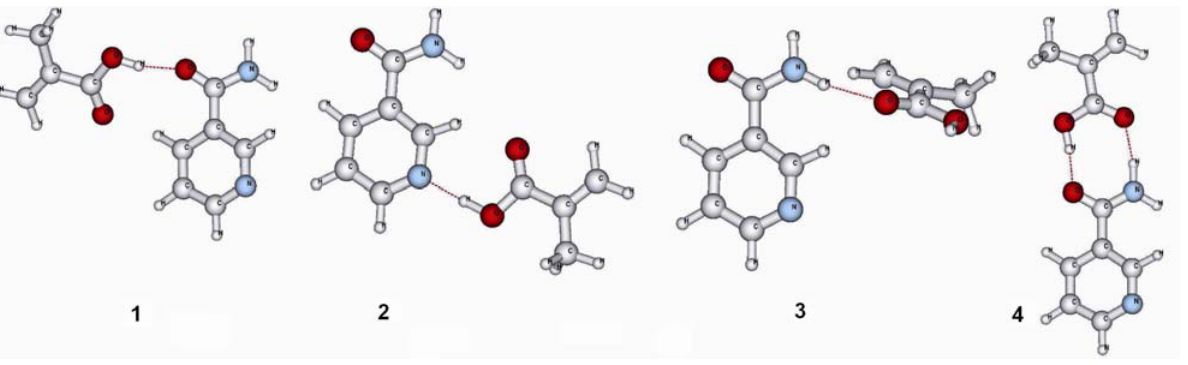
Figure 2. Schematic representation of all possible 1:1 complexes between nia template and MAA functional monomer.